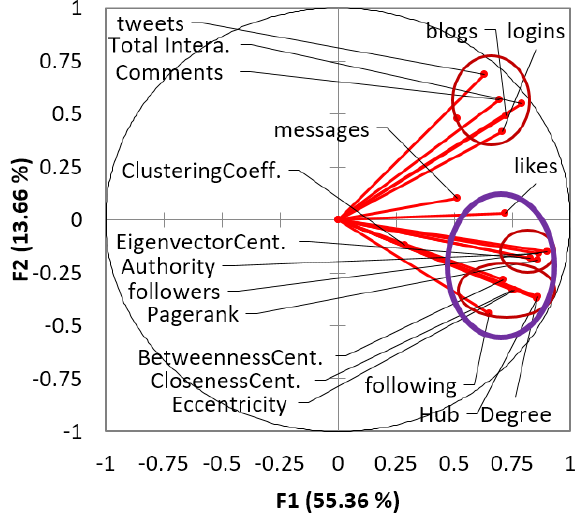
Figure 5. PCA factor loading biplot for the control group.